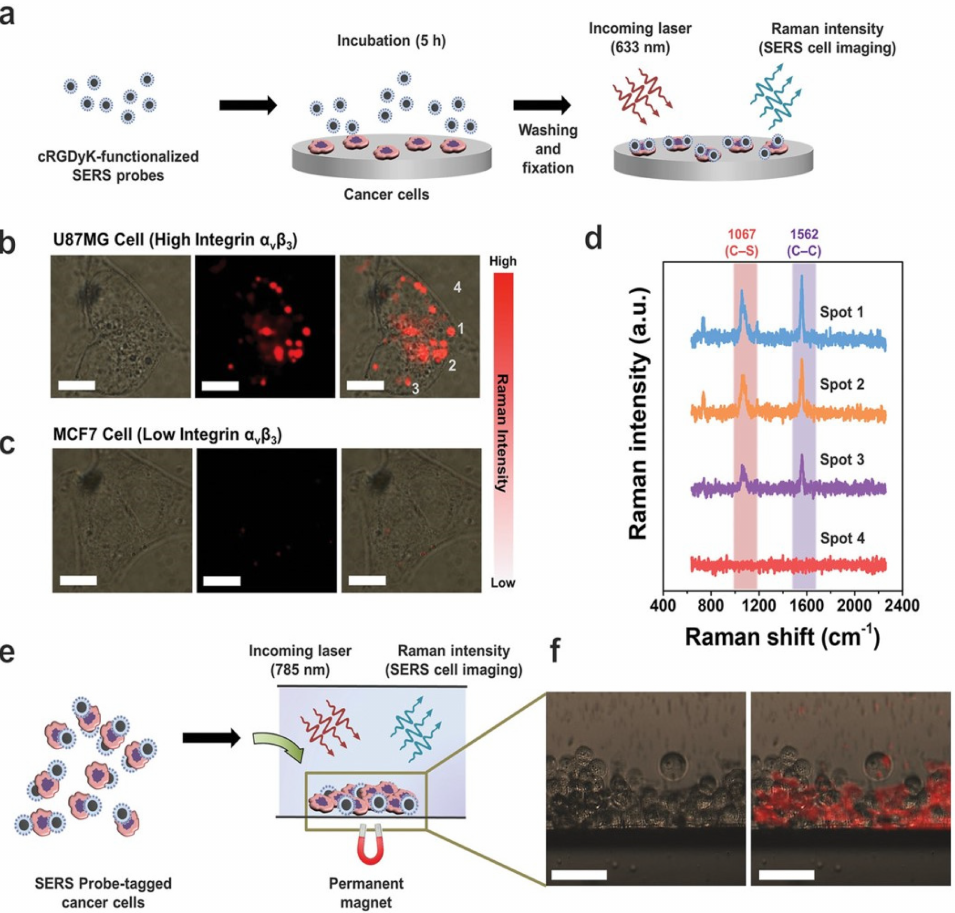
Figure 24. Targeted cell imaging and cell separation using cRGDyK-functionalized SERS probes. ( a ) Schematic of target-specific SERS cell imaging. ( b ) A bright-field image, Raman mapping, and merged image of U87MG cells with cRGDyK-functionalized SERS probes. ( c ) A bright-field image, Raman mapping, and merged image of MCF7 cells with cRGDyK-functionalized SERS probes. The scale bars in ( b , c ) are 10 µ m. ( d ) SERS spectra were obtained from the points in Figure 24b. ( e ) Schematic of magnetic separation of SERS probe-tagged cancer cells. ( f ) A bright-field image and merged image with a Raman mapping data of separated U87MG cells by cRGDyK-functionalized SERS probes. The scale bars are 50 µ m. Reprinted with permission from [136]. Copyright 2020